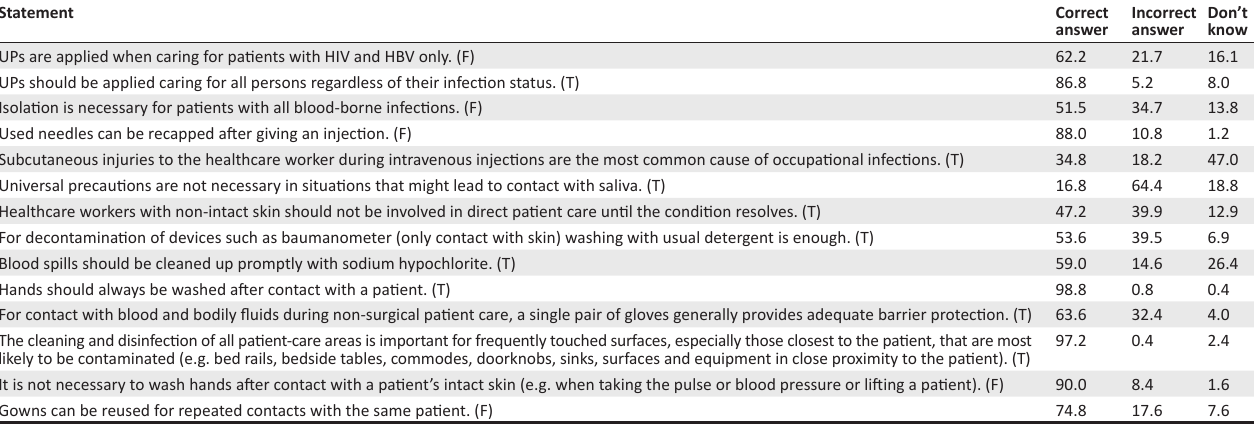
TABLE 2: Knowledge of the UPs.